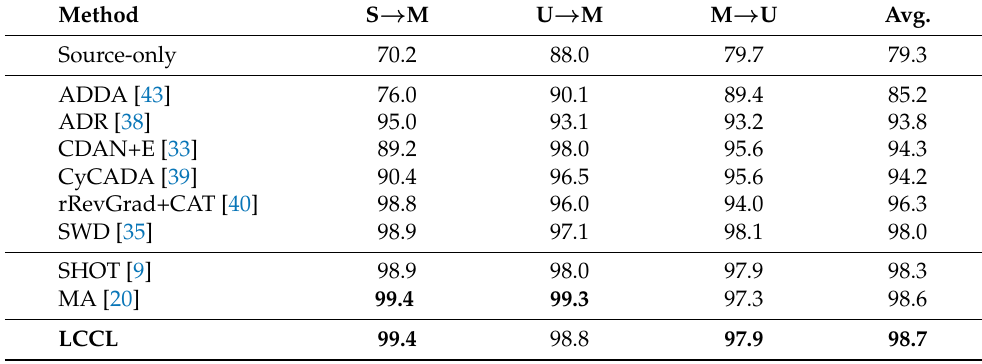
Table 2. Classification accuracies (%) on Digits dataset (LeNet-5). S: SVHN, M:MNIST, U: USPS.